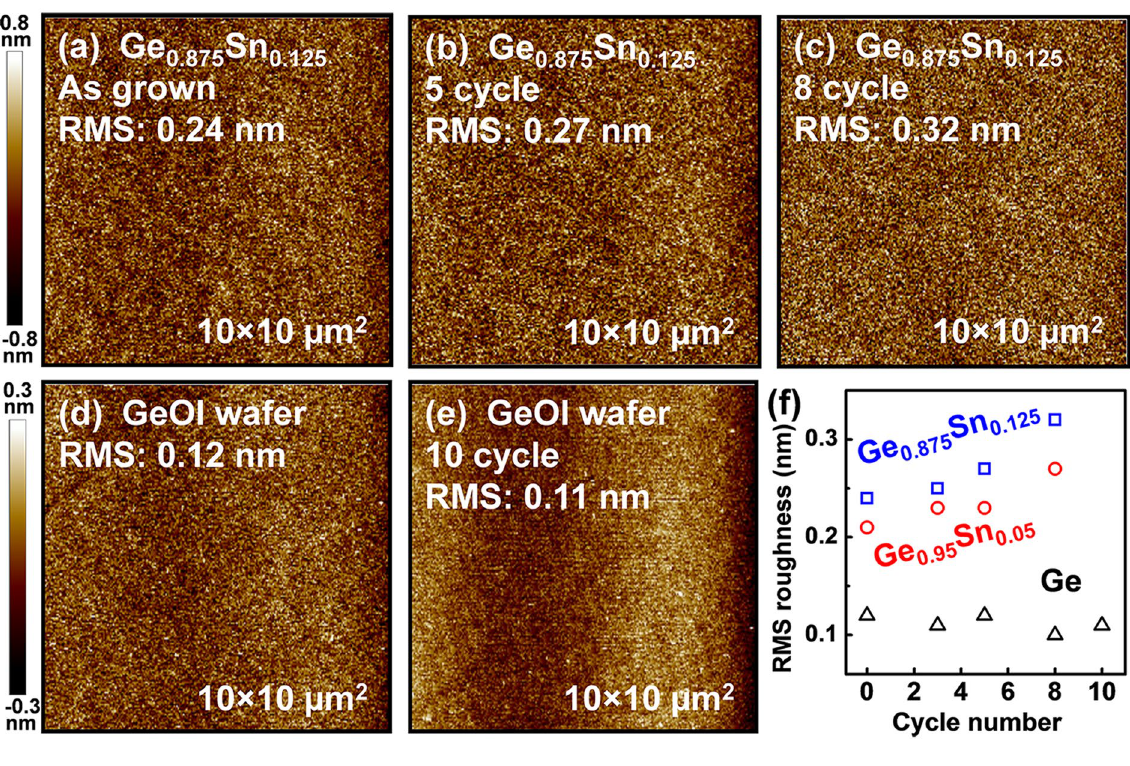
Figure 5. AFM images of ( a ) the as grown Ge 0.875 Sn 0.125 , and the sample after ( b ) 5 cycle and ( c ) 8 cycle digital etch. AFM images of ( d ) the GeOI sample, and the sample after ( e ) 11 cycle digital etch. ( f ) Surface RMS roughness evolution with cycle number. The Ge 1 − x Sn x surface remains smooth after digital etch.